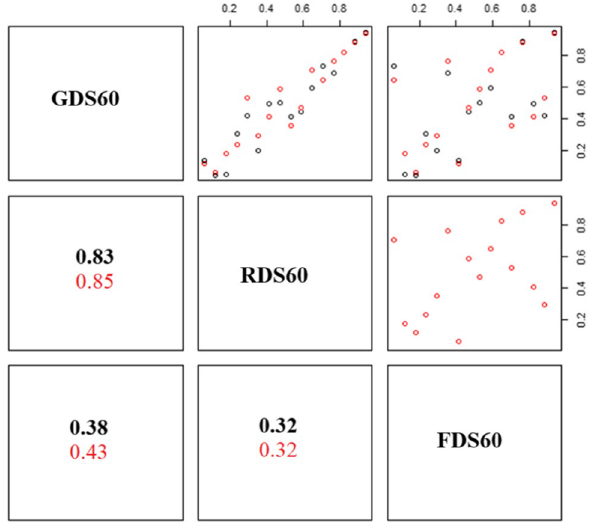
Fig. 11 Results of groundwater level deficiency signature simulation in Tapik basin on the copula scale